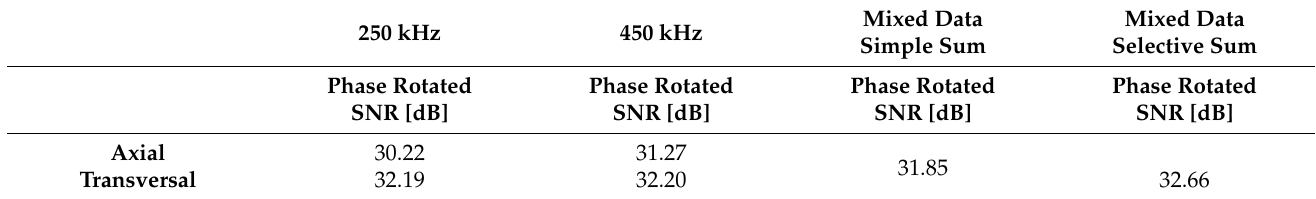
Figure 11. Mixed vertical impedance component C − scan. Table 3. Mixed Image